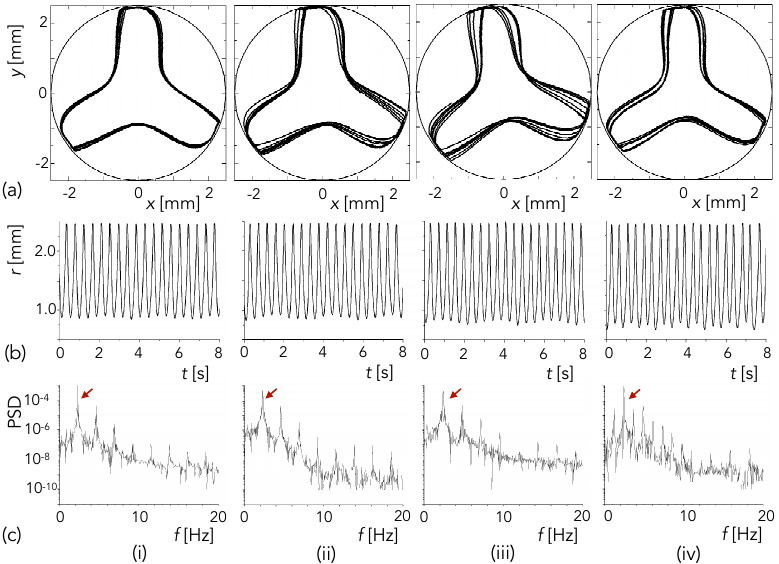
Figure 6. ( a ) Reconstructed SL1-PAS configurations in a rotating frame of reference by tracking a single particle forming PAS, ( b ) time series of particle radial positions, and ( c ) its power spectral density (PSD) for Ma of ( i ) 3.3 × 10 4 , ( ii ) 3.7 × 10 4 , ( iii ) 4.2 × 10 4 , and ( iv ) 4.6 × 10 4 , respectively. Conditions of the liquid bridge are the same as indicated in Figure 4. The particle diameter is 15µm. Arrows in row ( c ) indicate the fundamental frequency of the particle turnover motion f evaluated by applying H for the characteristic length L . (Figure 9 in Gotoda et al.